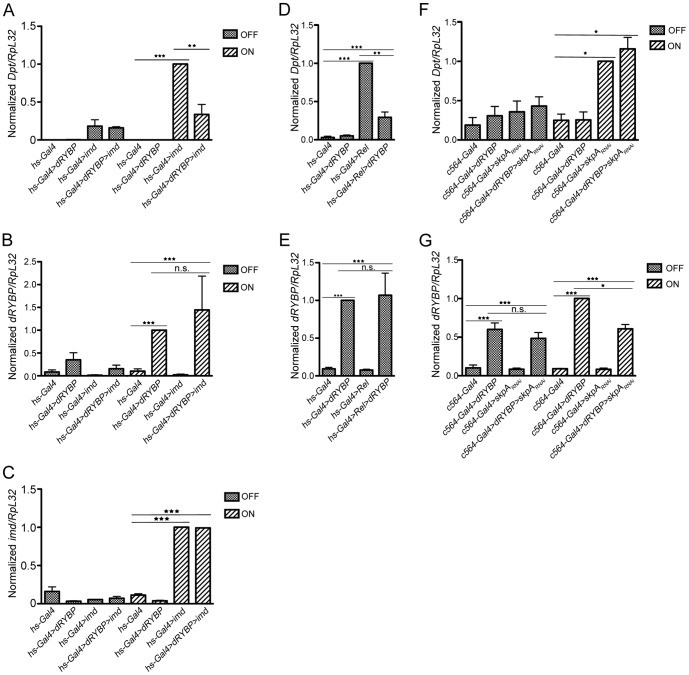
Epistatic relationships between dRYBP and components of the Imd pathway.(A) dRYBP acts downstream of IMD. Flies overexpressing dRYBP, imd, or both under the control of a heat-shock-inducible promoter were kept at 18°C (OFF) or exposed to 37°C for 1 h, then shifted to 29°C for 7 h (ON), at which point Dpt mRNA levels were assessed to measure Imd pathway activity. (B, C) Overexpression of multiple UAS constructs does not lead to Gal4 dilution. (B) shows qRT-PCR quantification of mRNA levels of dRYBP expression. dRYBP expression is increased under induced conditions (compare hs-Gal4 to hs-Gal4;UAS-dRYBP) and does not significantly change when two UAS constructs are concomitantly expressed (compare hs-Gal4;UAS-dRYBP to hs-Gal4,UAS-imd/UAS-dRYBP). (C) shows qRT-PCR quantification of mRNA levels of imd expression. imd expression is increased under induced conditions (compare hs-Gal4 to hs-Gal4,UAS-imd) and does not significantly change when two UAS constructs are concomitantly expressed (compare hs-Gal4,UAS-imd to hs-Gal4,UAS-imd/UAS-dRYBP). (D) dRYBP acts downstream of Relish. Flies overexpressing dRYBP, Rel (Relish-His-6), or both under the control of a heat-shock-inducible promoter were kept at 18°C, which induces low overexpression of all constructs. Dpt mRNA levels were assessed as a measure of Relish-dependent transcriptional activation. (E) qRT-PCR quantification of mRNA levels of dRYBP expression in the same crosses. dRYBP expression is increased when overexpressed with hs-Gal4 in flies kept at 18°C (compare hs-Gal4 to hs-Gal4;UAS-dRYBP) and does not significantly change when two UAS constructs are concomitantly expressed (compare hs-Gal4;UAS-dRYBP to hs-Gal4/UAS-Relish-His-6;UAS-dRYBP). (F) dRYBP acts upstream of SKPA. Flies overexpressing dRYBP, RNAi against skpA, or both under the control of the fat-body specific driver c564-Gal4 were either kept at 18°C (OFF) or shifted to 29°C for 24 h (ON), at which point Dpt mRNA levels were assessed to measure Imd pathway activity. (G) qRT-PCR quantification of mRNA levels of dRYBP expression. dRYBP expression is increased under induced conditions (compare c564-Gal4 to c564-Gal4;UAS-dRYBP) and does not significantly change when two UAS constructs are concomitantly expressed (compare c564-Gal4;UAS-dRYBP to c564-Gal4;UAS-dRYBP/UAS-skpARNAi). Asterisks denote the following p values: *, 0.01<p<0.05; **, 0.001<p<0.01; *** p<0.001; ns, not significant. Data represent mean + SEM of 3 biological repeats.